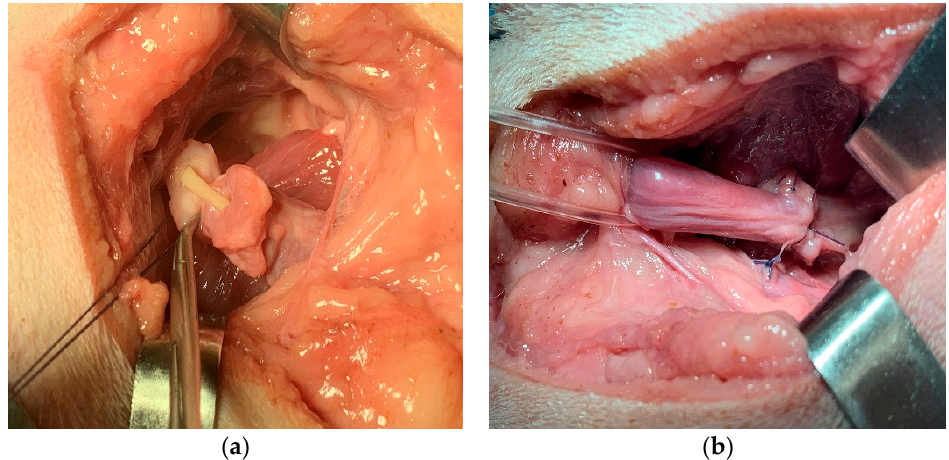
Figure 4. Surgery steps: ( a ) the catheter is reintroduced into the urethra to realign the stumps